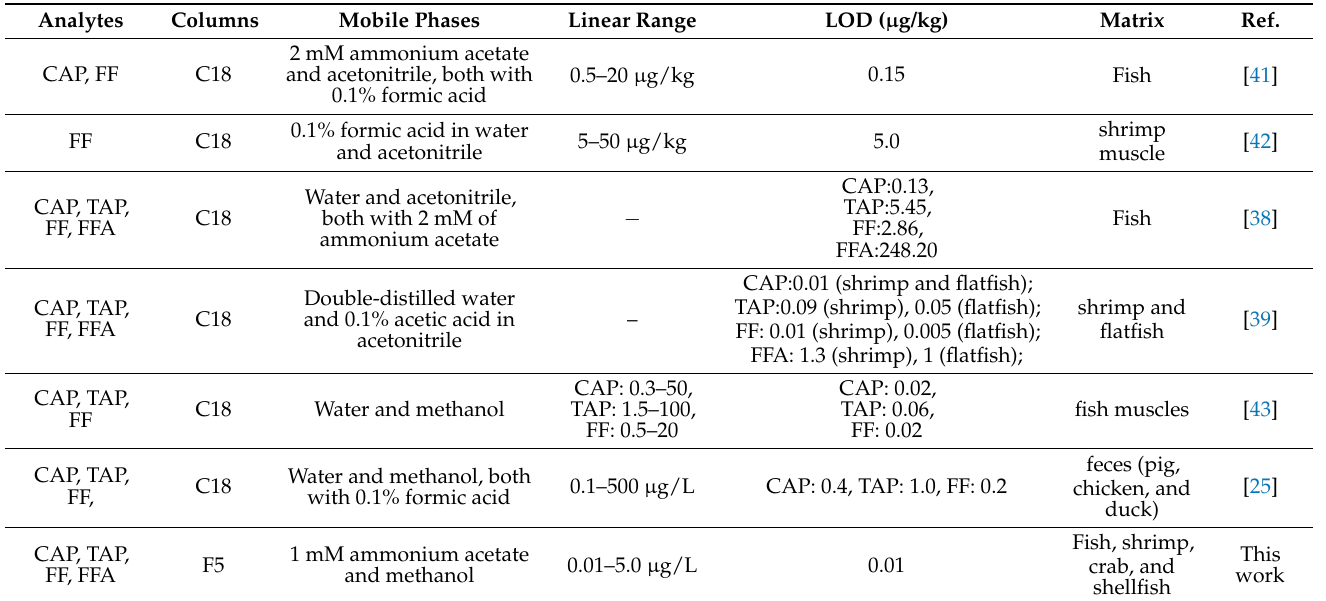
Table 2. Comparison of amphenicol determination reported in the literature using the HPLC– MS/MS